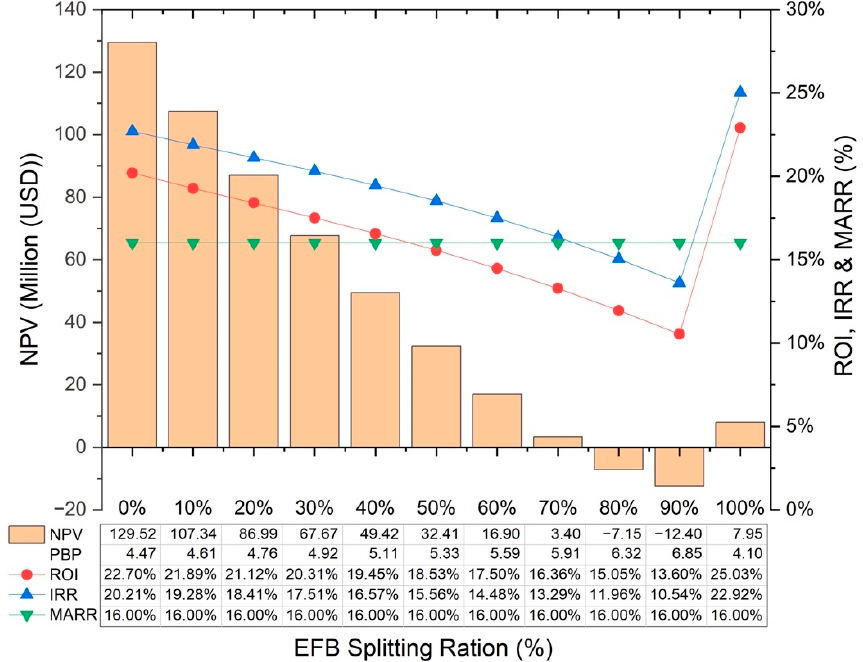
Figure 3. Economic profitability analysis at different EFB splitting ratios to pellet production.